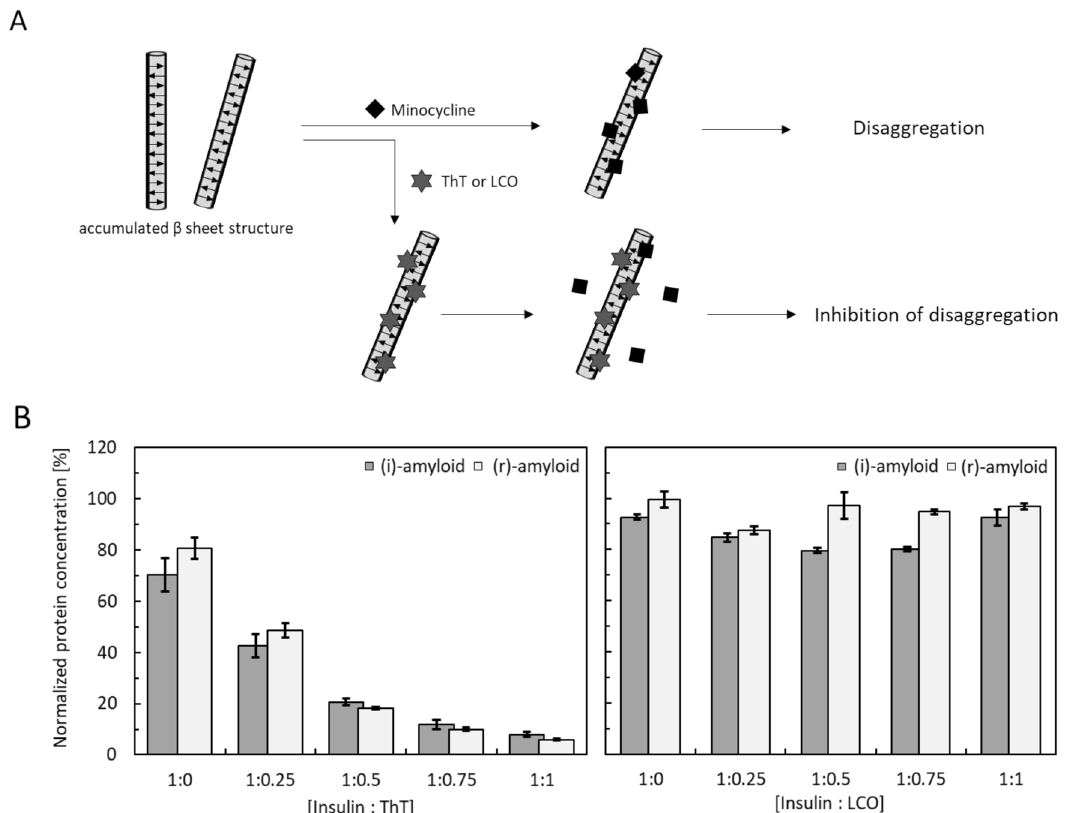
Figure 5. Identification of the binding site of minocycline to insulin amyloids. ( A ) Scheme of a model of insulin amyloid blocked by fluorescence probes at the minocycline binding site. ( B ) BCA assay of supernatant samples of (i)-amyloid and (r)-amyloid blocked by ThT (left) and LCOs (right) to confirm the identification of the binding site of minocycline in insulin amyloid: (i)-amyloid (gray) and (r)-amyloid (white). pFTAA and BTD 21 were used for (i)-amyloid and (r)-amyloid, respectively. Protein concentration was normalized for 50 µM (all insulin amyloid